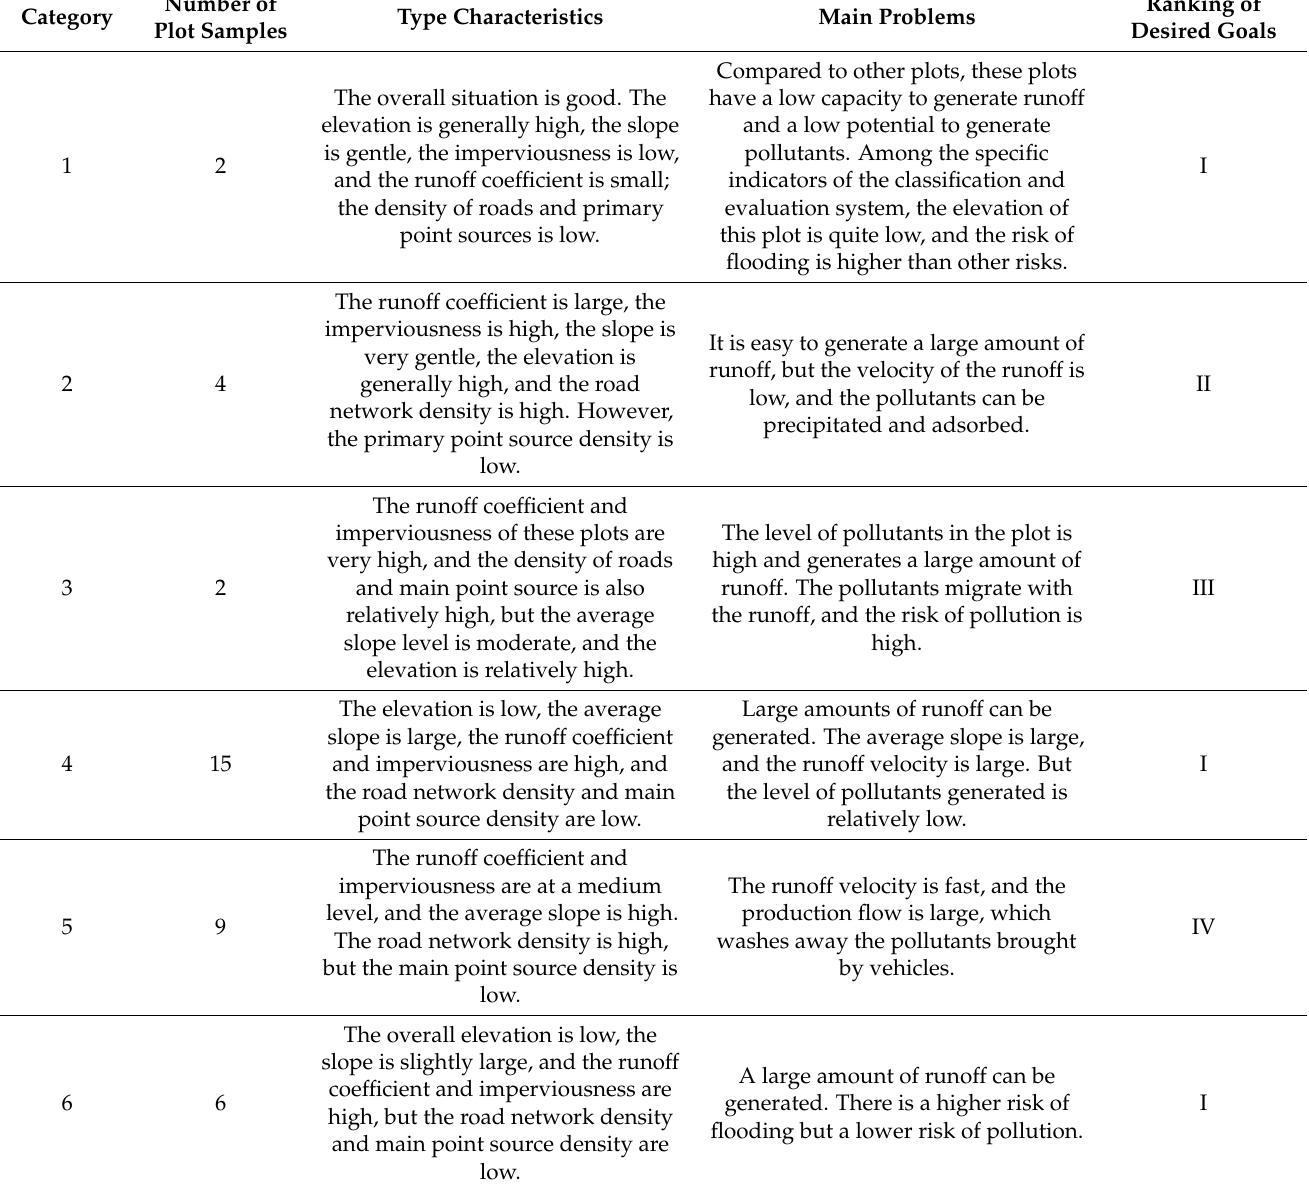
Table 5. K-means cluster analysis results and analysis of